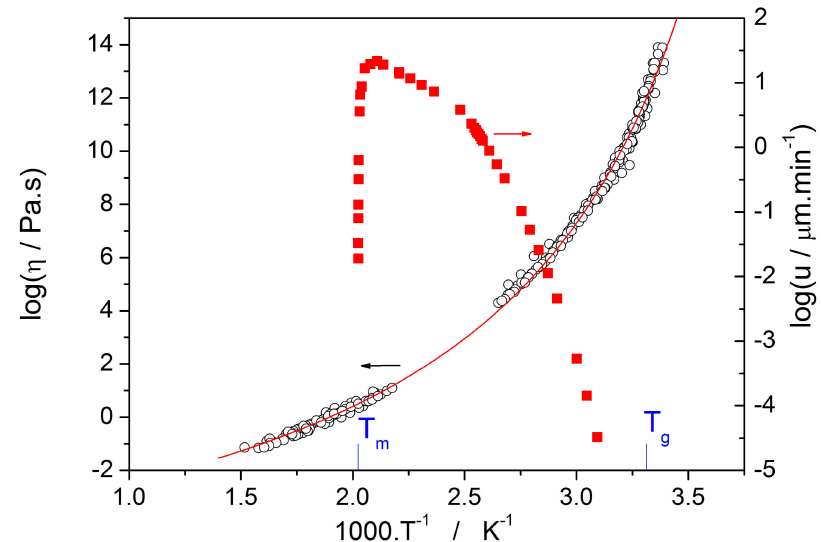
Figure 4. The crystal growth rate of isothermally grown spherulitic crystals and viscosity of a selenium supercooled liquid as a function of reciprocal temperature.